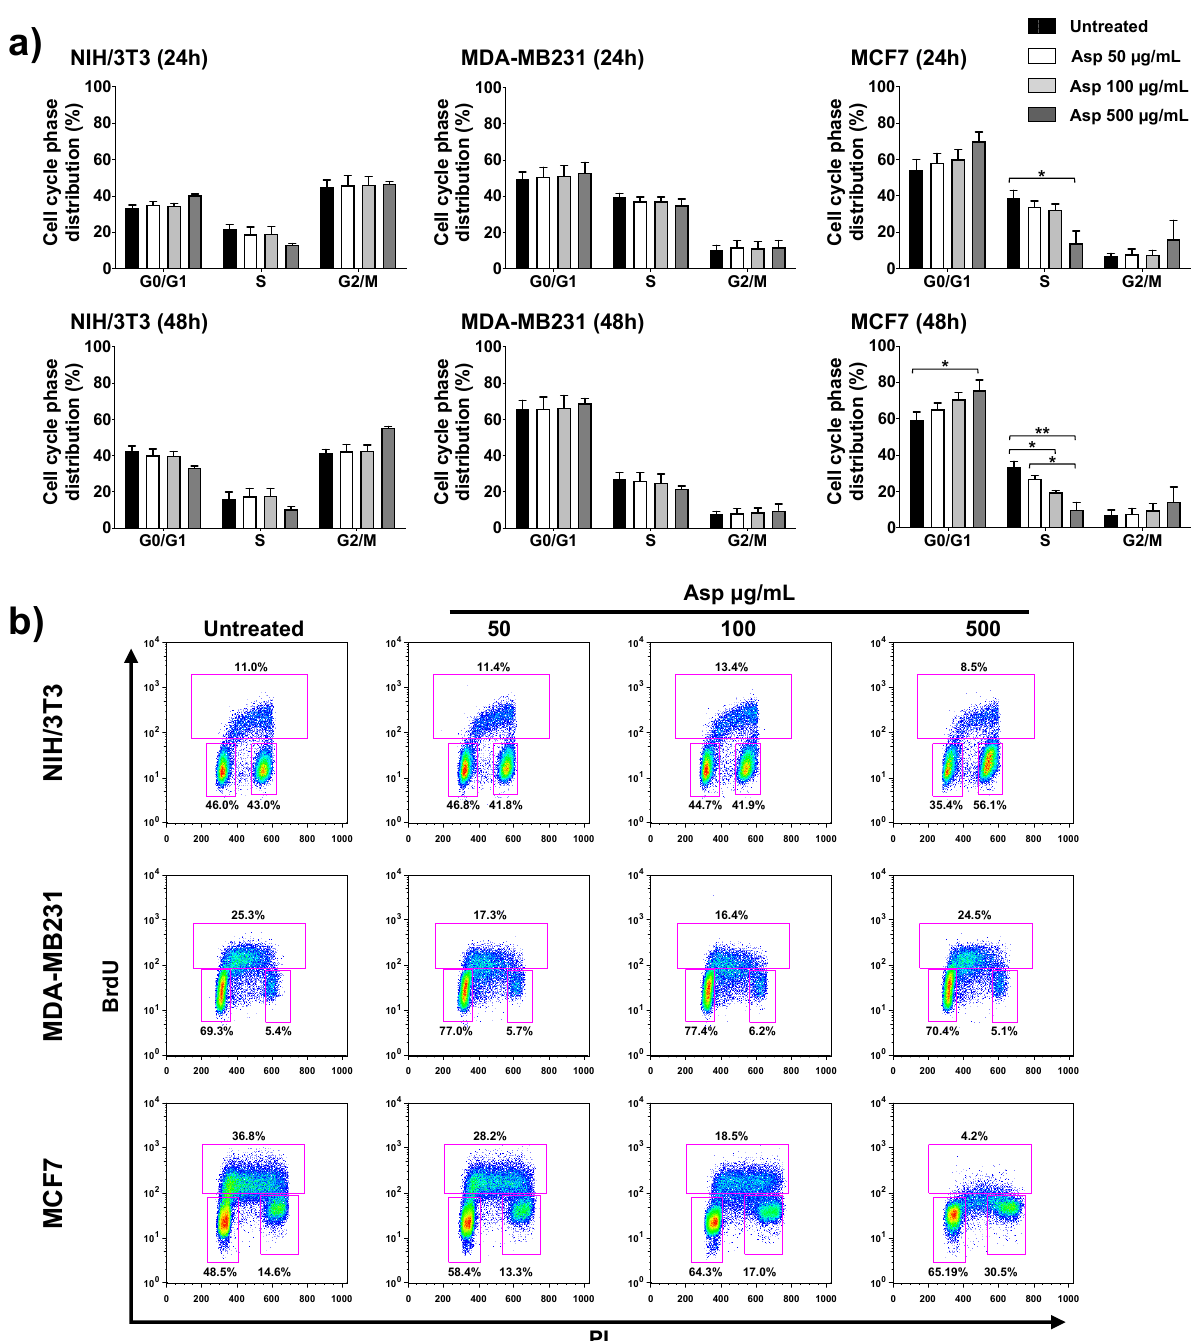
Figure 4. NIH/3T3; MDA-MB231; MCF7 cell distribution in the different phases of the cell cycle calculated from the flow cytometry dot plots after BrdU/PI staining of cultures after 24 or 48 h. ( a ) Results from cells untreated or treated with 50, 100, and 500 μ g/mL of Asp extracts were expressed as a percentage of the total population. Data are reported as mean ± standard error from three independent experiments. Statistical analysis was performed by ANOVA followed by Bonferroni’s post hoc test. p -values ≤ 0.05 were considered significant: * p ≤ 0.05, ** p ≤ 0.01; ( b ) Representative flow cytometry dot plots of cell cycle profiles after 48 h of treatments. The PI axes scale is reported as linear and the BrdU axes scale is reported as logarithmic.